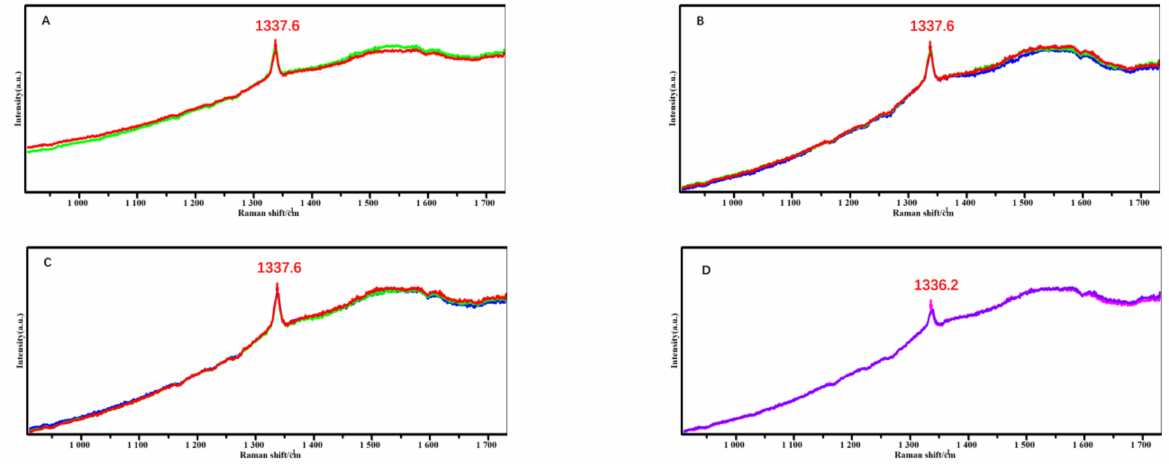
Figure 6. Raman spectra of diamond coatings on milling tools with different pretreatment schemes. ( A ) Scheme A (Acid etching 30 s); ( B ) Scheme B (Acid etching 20 s); ( C ) Scheme C (Acid etching 15 s); ( D ) Scheme D (Acid etching 10